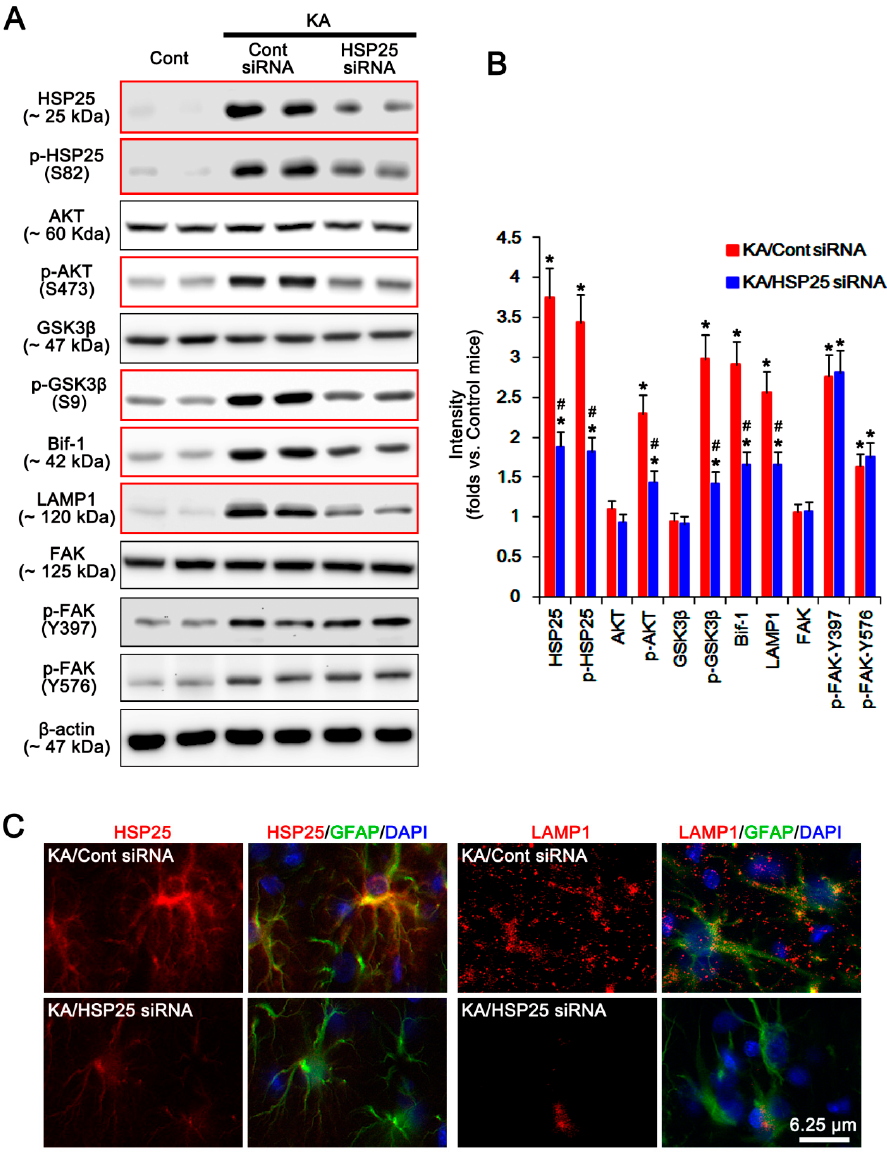
Figure 8. E ff ects of HSP25 knockdown on expressions and phosphorylations of HSP25, AKT, GSK3 β , Bif-1, LAMP1, and FAK in KO astrocytes following KA injection. HSP25 knockdown abrogates upregulations of HSP25, p-HSP25, p-AKT-S473, p-GSK3 β -S9, Bif-1, and LAMP1 induced by KA, while it does not affect FAK and its phosphorylations, 7 days after KA injection (red box). ( A ) Representative Western blot of expressions and phosphorylations of HSP25, AKT, GSK3 β , Bif-1, LAMP1, and FAK in KO astrocytes. Cont, control animals; KA, KA-injected animals. ( B ) Quantifications of expressions and phosphorylations of HSP25, AKT, GSK3 β , Bif-1, LAMP1, and FAK in KO astrocytes following KA injection (mean ± SEM; * ,# p < 0.05 vs. control KO astrocytes and control siRNA, respectively; n = 7, respectively). ( C ) E ff ects of HSP25 knockdown on HSP25 and LAMP1 expression in the hippocampal astrocytes. As compared to control siRNA, FI14 abrogates LAMP1, but not HSP25, expression in KO mice 7 days after KA